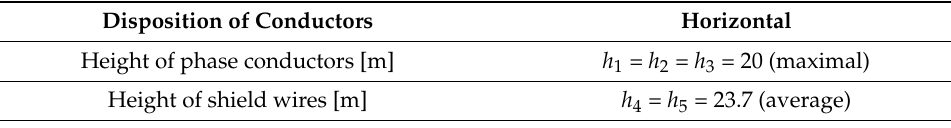
Table A1. Geometrical 400 kV power-line data.